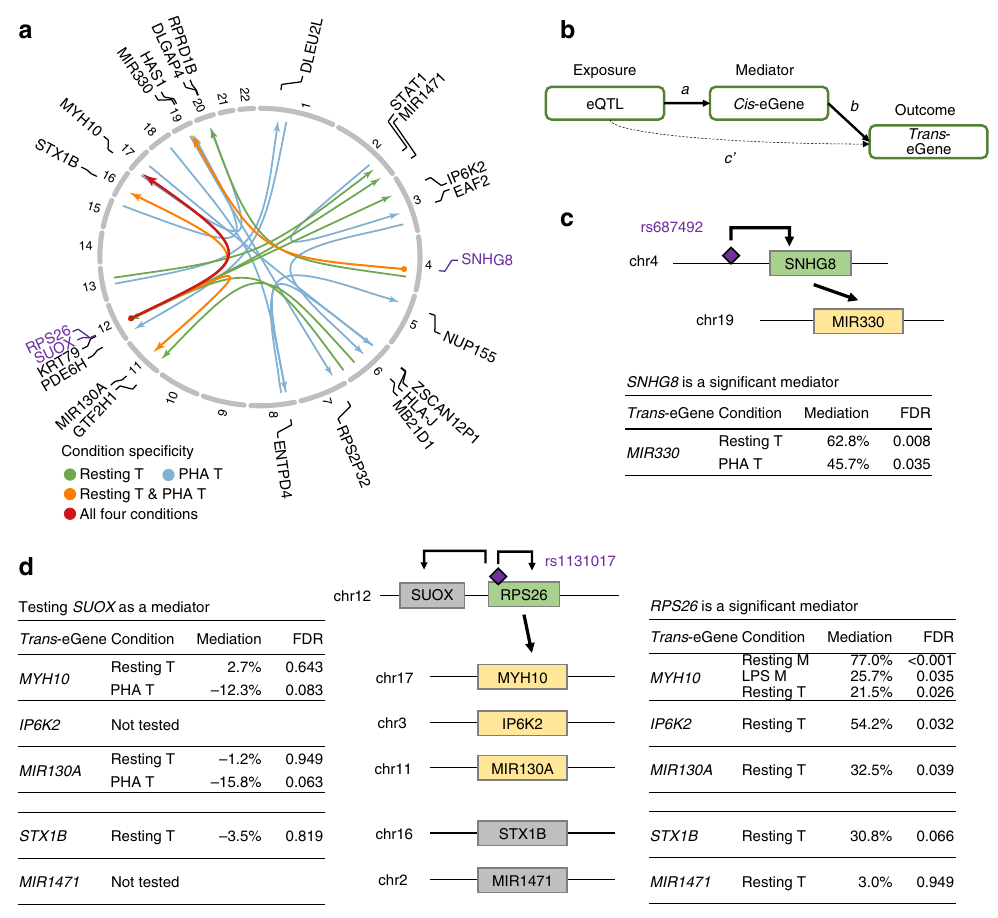
Fig. 3 Trans -eQTL effects and their cis- mediators. a A circular plot shows trans -eQTL associations in lines, with arrows pointing to trans -eGenes with names annotated (in black) outside the rim indicating chromosome numbers. Dots on the other end point indicate nearby genes (names in purple) that are associated with the same loci ( cis -eQTLs). Colours of the lines indicate the experimental conditions where the trans -eQTLs were identi fi ed: resting T cells only (Resting T), stimulated T cells only (PHA T), shared between both conditions of T cells (Resting T & PHA T), and shared across all four experimental conditions (All four conditions). b A diagram demonstrates the mediation analysis model, where effects of trans -acting eQTL (exposure) on trans- eGene (outcome) are either mediated through a cis- eGene (mediator), or through direct effects ( ‘ Methods ’ ). c , d Show two examples of cis -eGenes (green), SNHG8 and RPS26 , acting as mediators for trans -effects ( trans -eGenes in yellow). Genes that were not signi fi cant in mediation analysis are in grey. Tables show statistics of the mediation tests, and the column named Mediation indicates the proportion of total effects of the eQTL on the trans -eGene that was mediated through the cis -eGene. Two models involving SUOX ( d ) were not tested because the trans -eSNPs of IP6K2 and MIR1471 were not signi fi cantly associated with SUOX (Supplementary Data 3). Signi fi cant mediations (FDR ≤ 0.05) are highlighted in